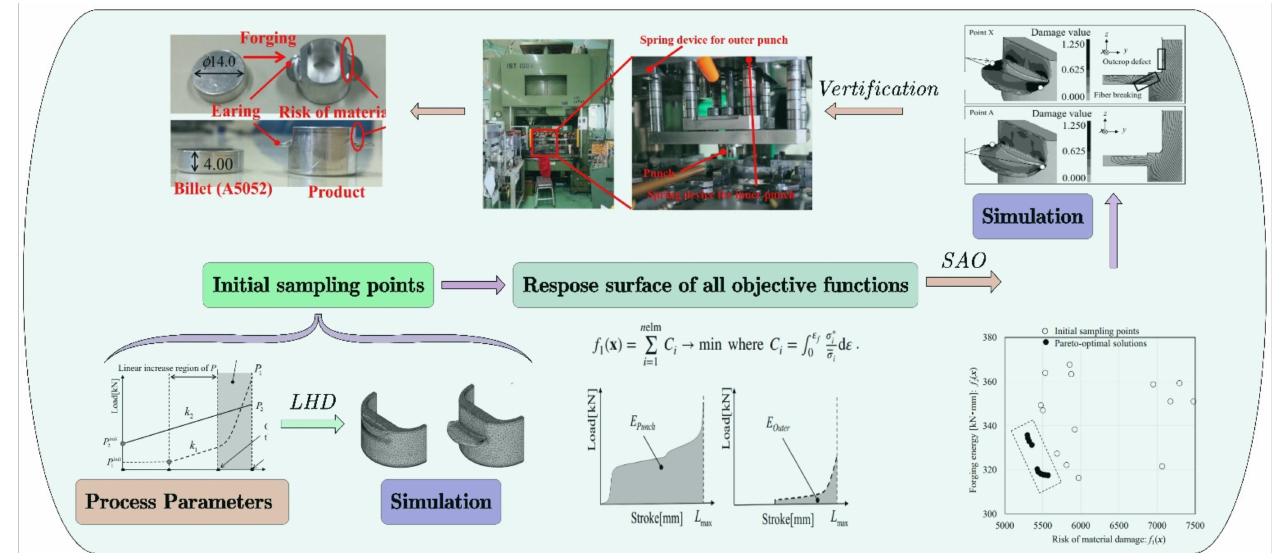
Figure 5. Minimizing risk of crack and forging energy based on a radial basis function-based SAO method